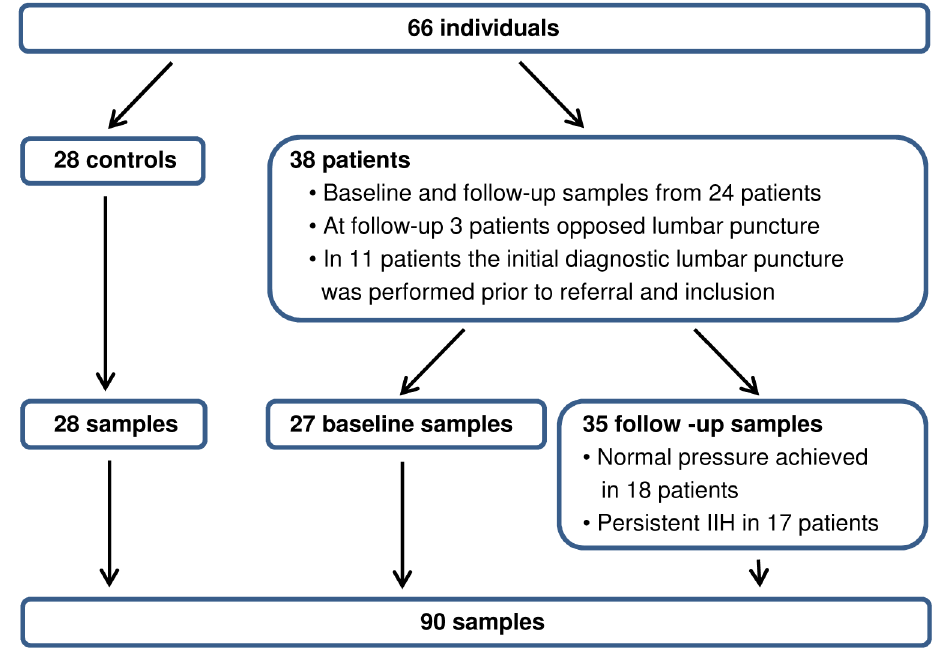
Fig 1. Participants and Samples.